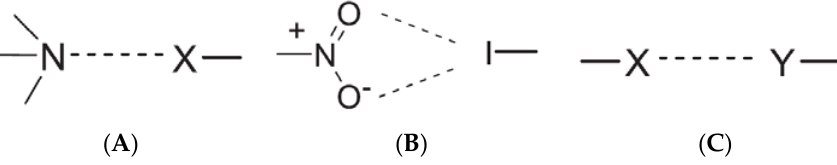
Figure 7. Schematic representation of supramolecular heterosynthons brought about by ( A ) Amine-halogen interaction, ( B ) Nitro-iodo interaction and ( C ) Halogen bonding (X-Halogens such as Cl, Br, I and Y-Electron pair donors such as N or O) [98] [Reprinted from [98] with permission from Elsevier].